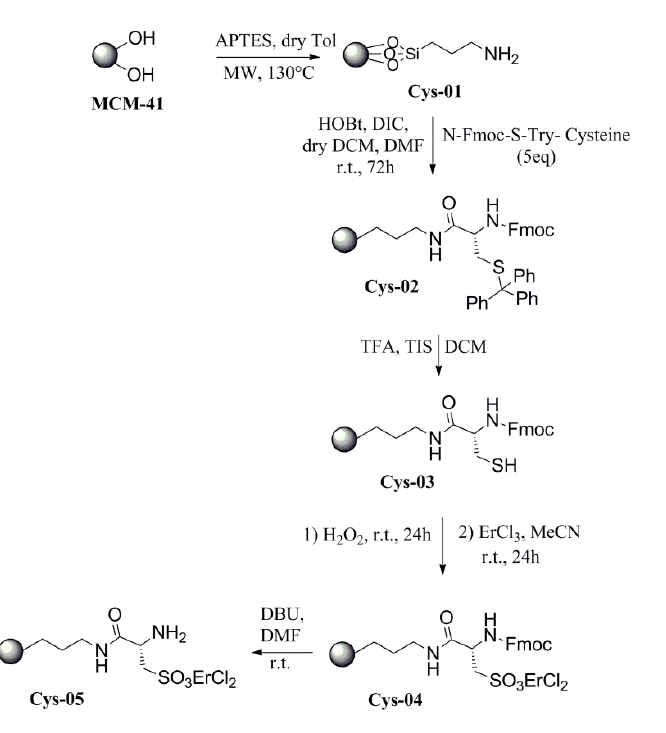
Figure 1. Schematic representation of Er-Cys05